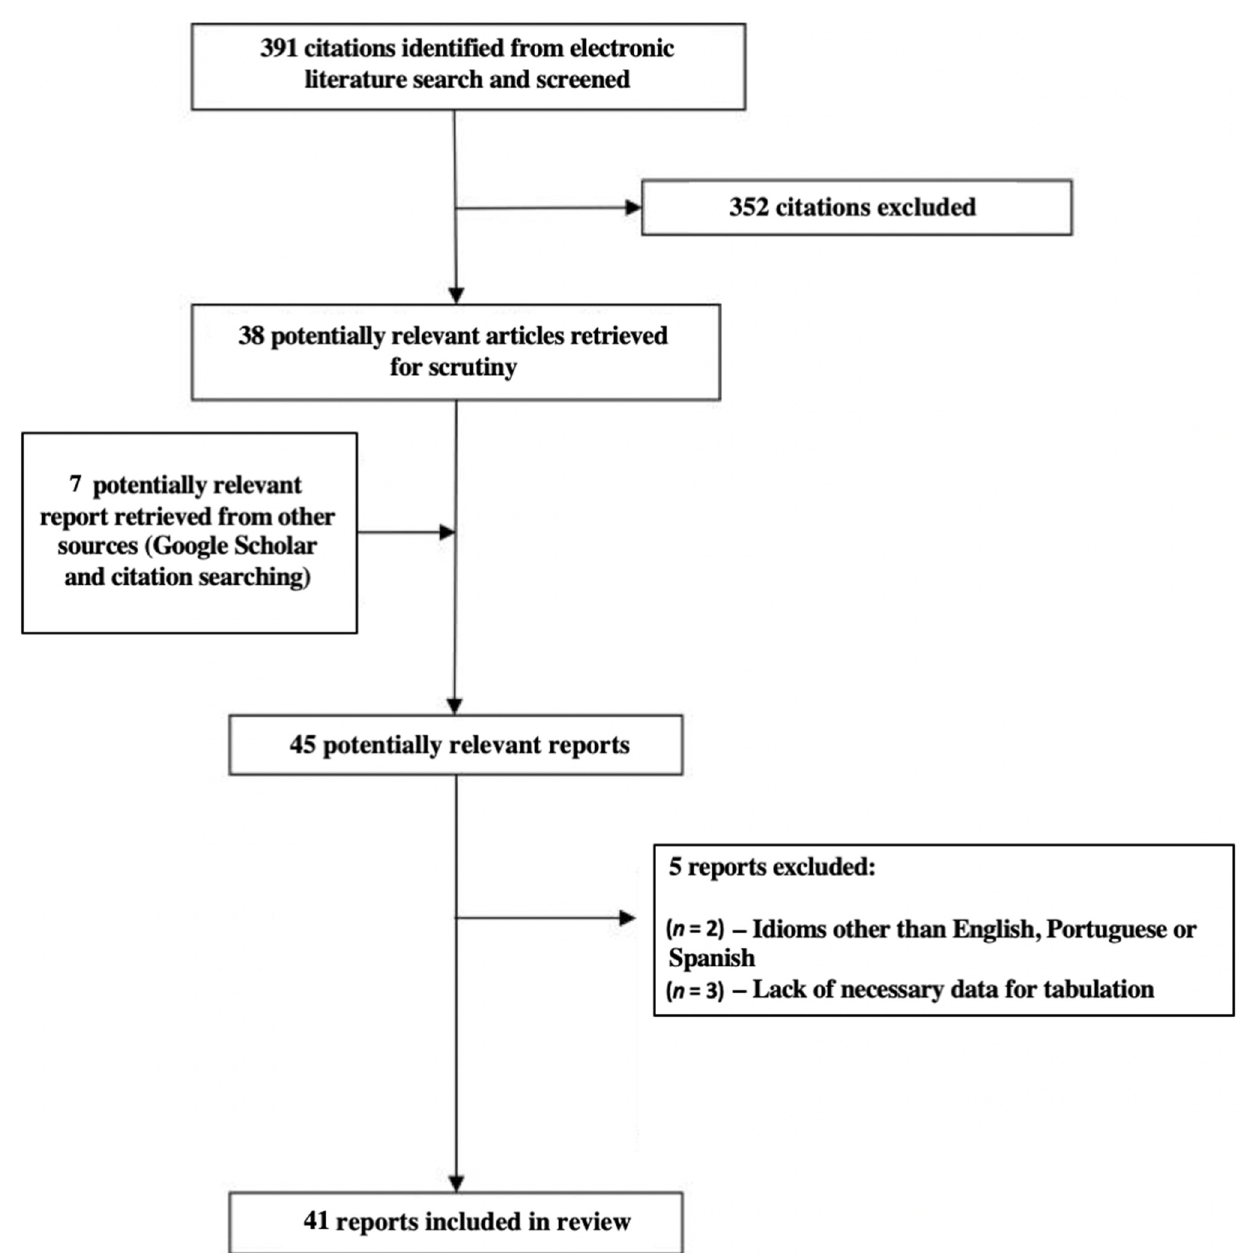
Figure 2. Flowchart of the search and selection of the articles.